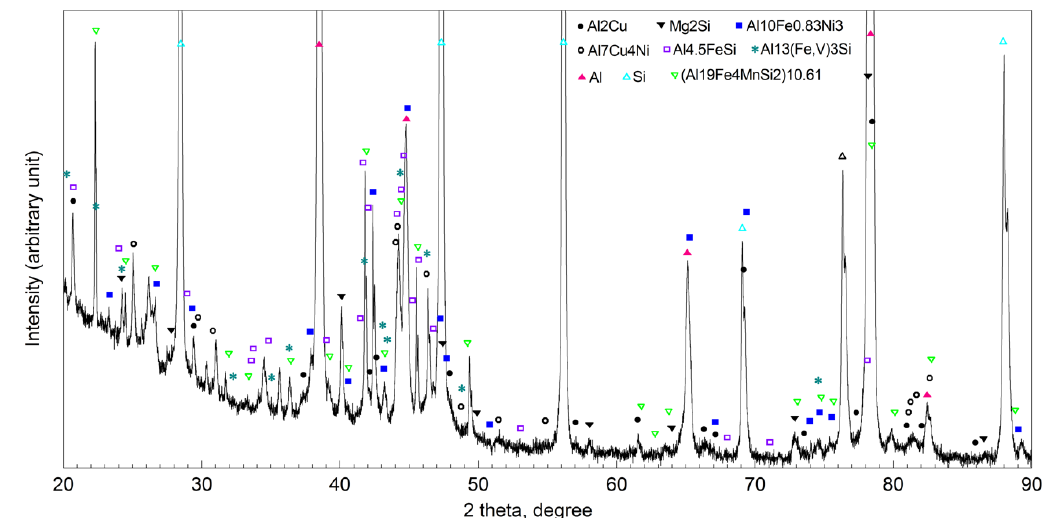
Figure 13. XRD patterns of Al-30 wt.% Si with Mn, Cu, Cr, Ni, V, Fe and Mg additions.